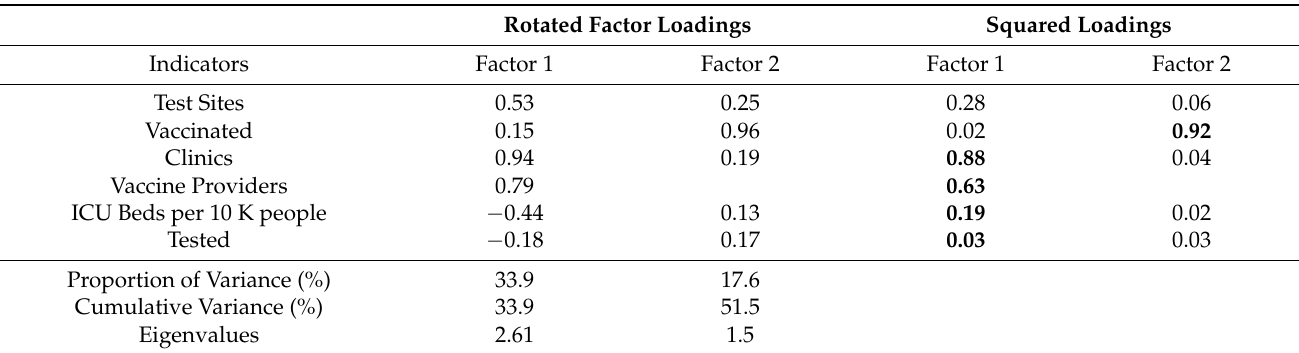
Table 5. Factor loadings for the adaptive capacity subindex.